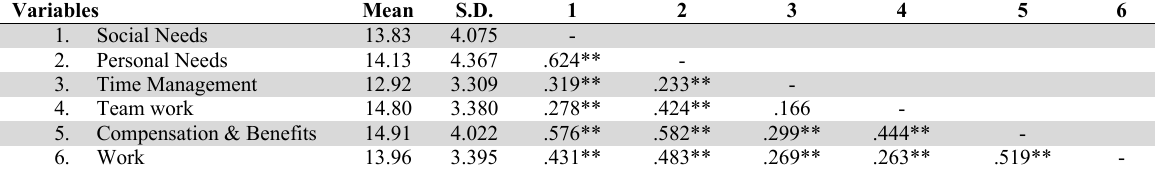
Representing Mean, std. deviation and correlations matrix of work-life balance and their aspects Variables Mean